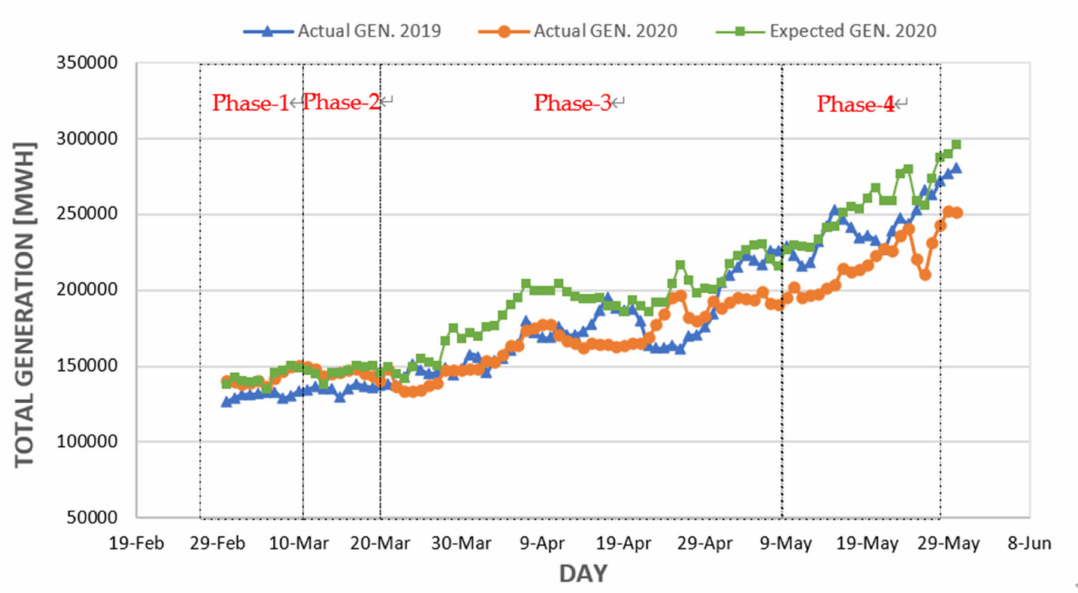
Figure 8. Total power generation in MWh over the test period 1st March–30